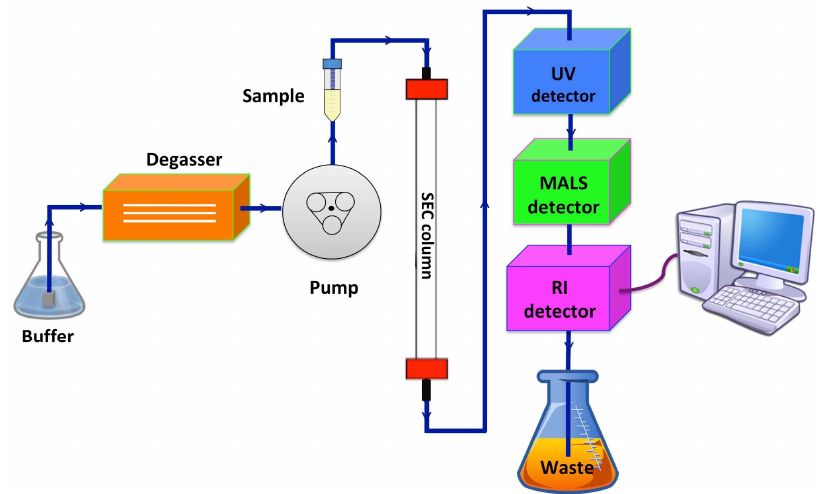
Figure 4. Schematic representation of a size-exclusion chromatography multi-angle light scattering (SEC-MALS) system. The buffer is de-gassed and pumped into the system. The sample is loaded into the system and carried through the size-exclusion chromatography (SEC) column where the size separation process takes place before the different components of the sample passes through the three detectors: a ultraviolet (UV) detector, a multi-angle light scattering (MALS) detector, and a refractive index (RI) detector. The detectors’ output signals are combined and analysed by the available software.